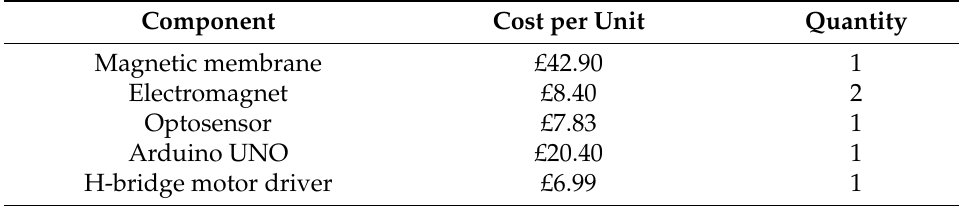
Table 1. Table of costs of actively control membrane circuit.